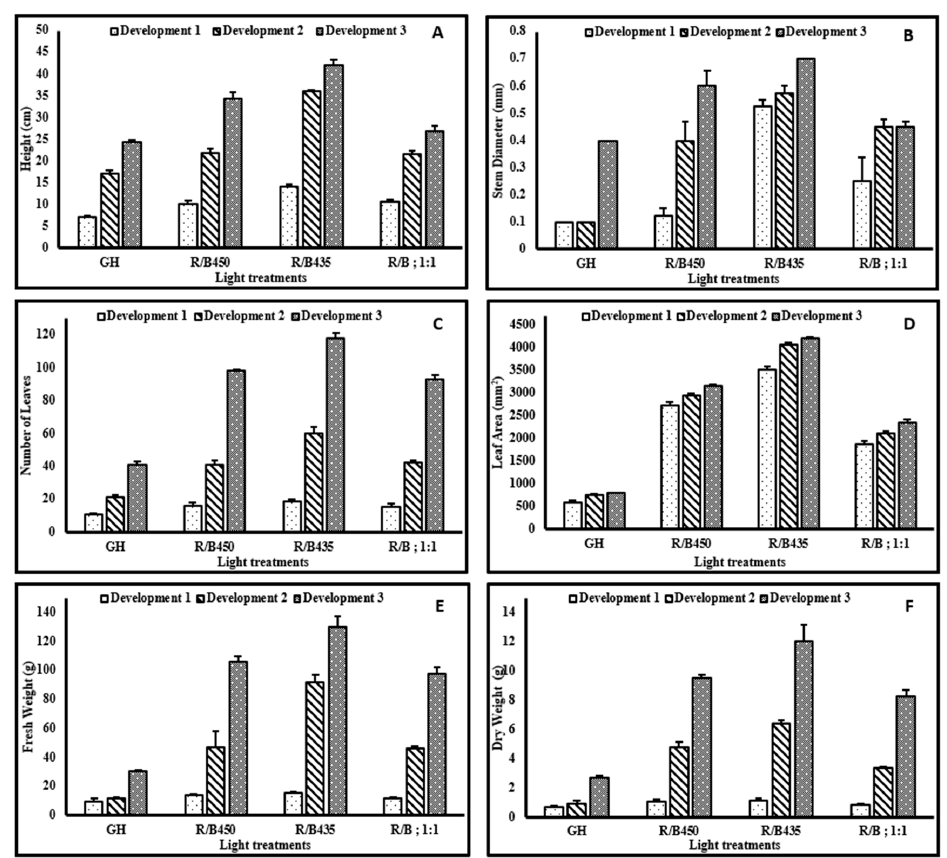
Figure 5. The effect of light treatment and development stage on the ( A ) height (H) (LSD = 1.96), ( B ) stem diameter (SD) (LSD = 0.09), ( C ) number of leaves (NL) (LSD = 5.01), ( D ) leaf area (LA) (LSD = 133.3), ( E ) fresh weight (FW) (LSD = 10.8) and ( F ) dry weight (DW) (LSD = 0.9) of sweet basil ( Ocimum basilicum ) in a plant factory and glasshouse